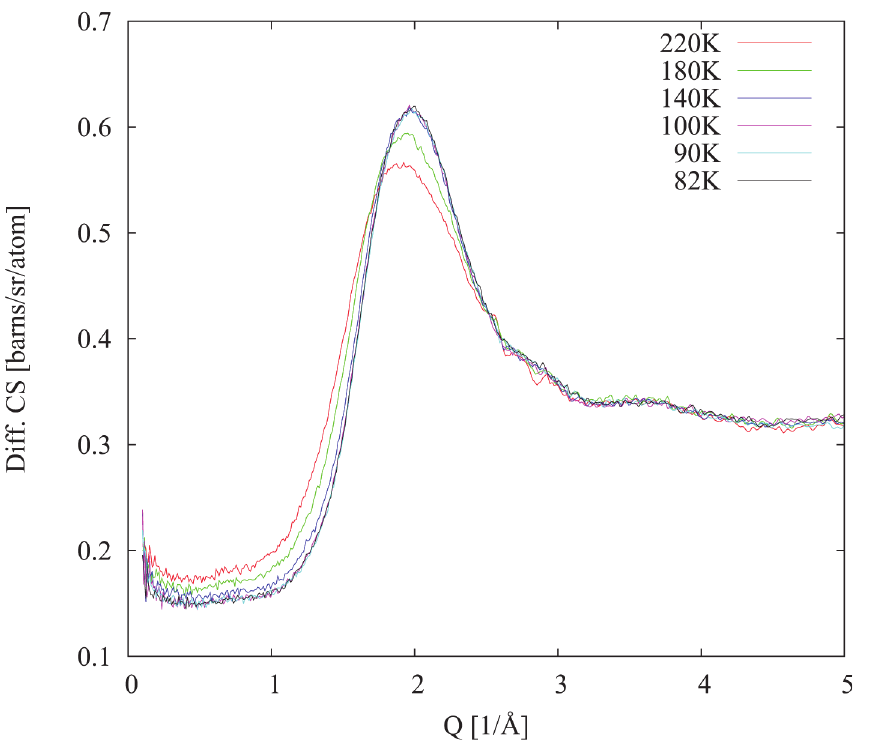
Fig 2. Differential cross sections for fully deuteriated sample. Cooling after first heating